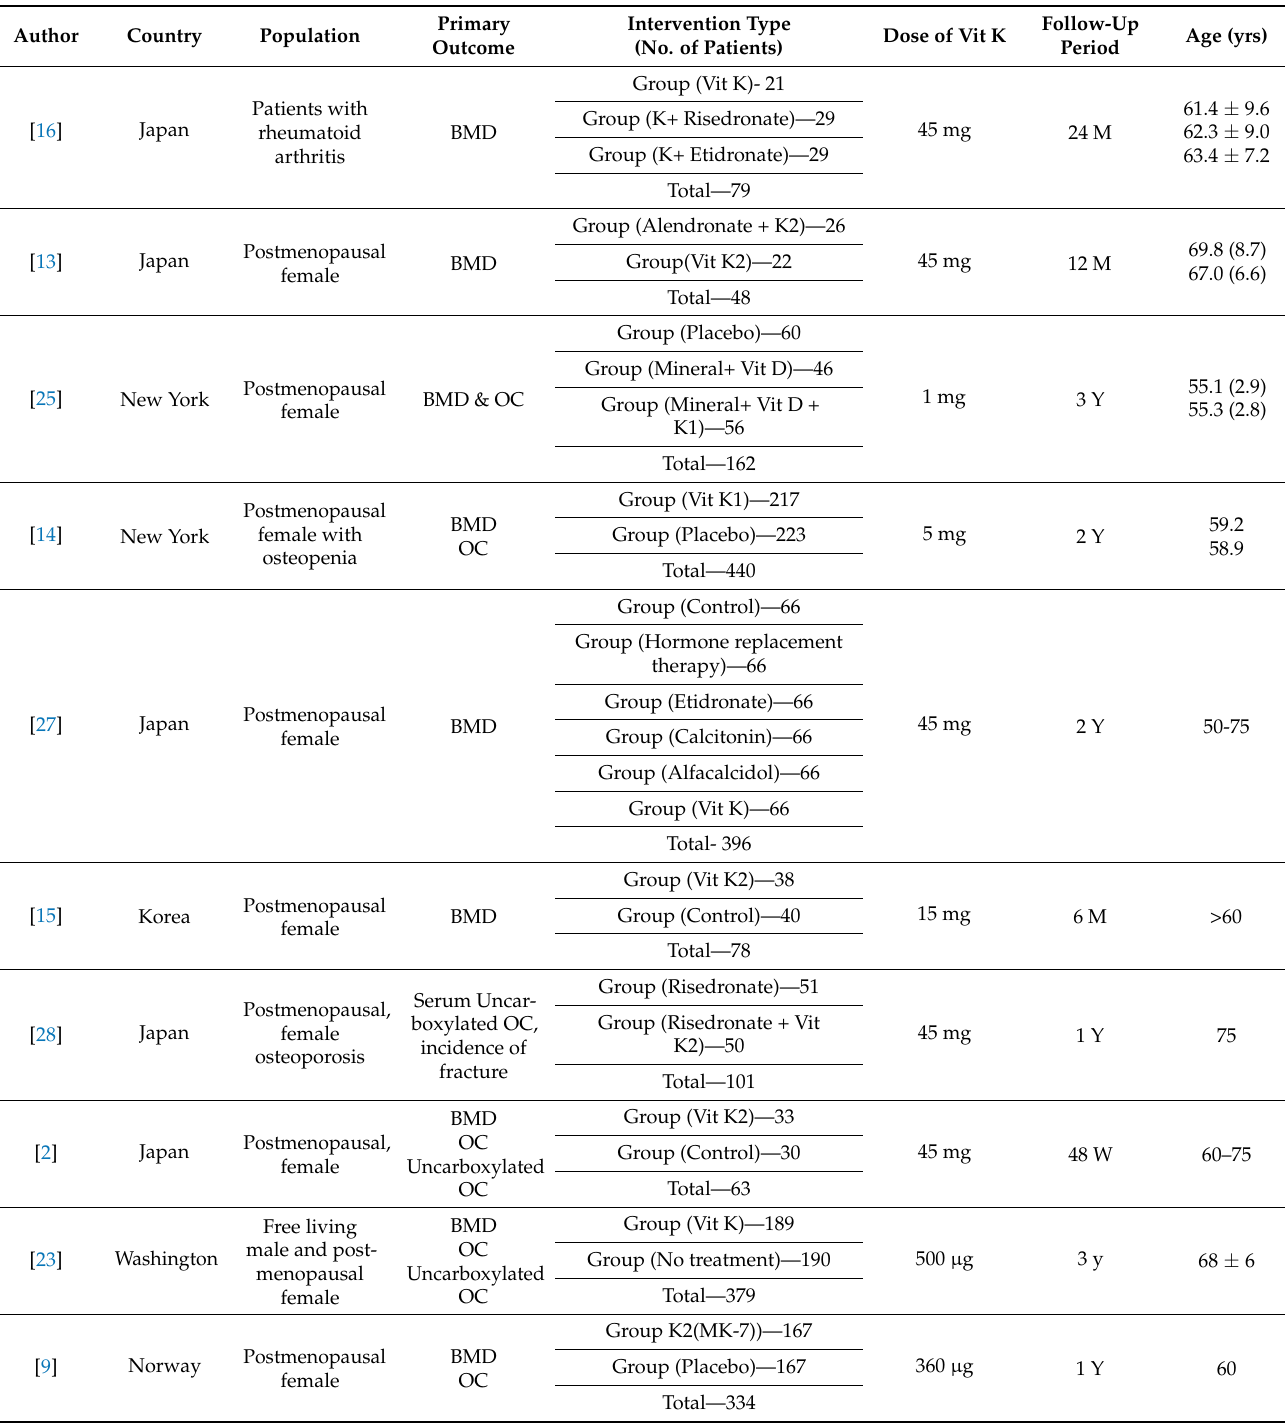
Table 2. Tabular representation of included